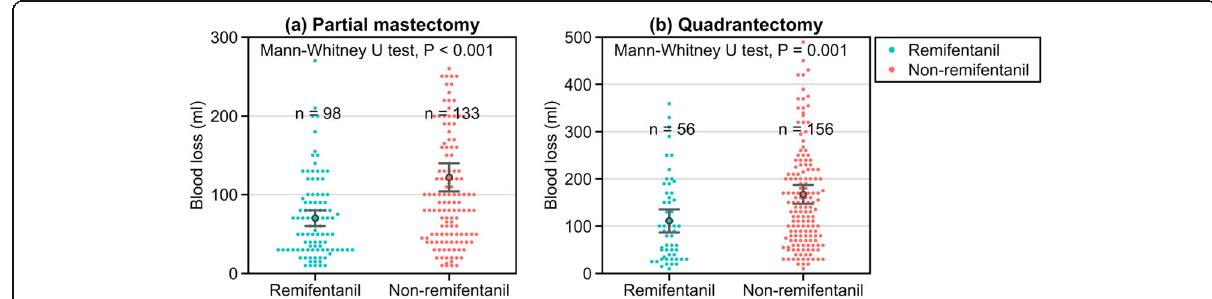
Fig. 2 Blood loss in mastectomies. Two types of mastectomies — partial mastectomy ( a ) and quadrantectomy ( b ) — were associated with a